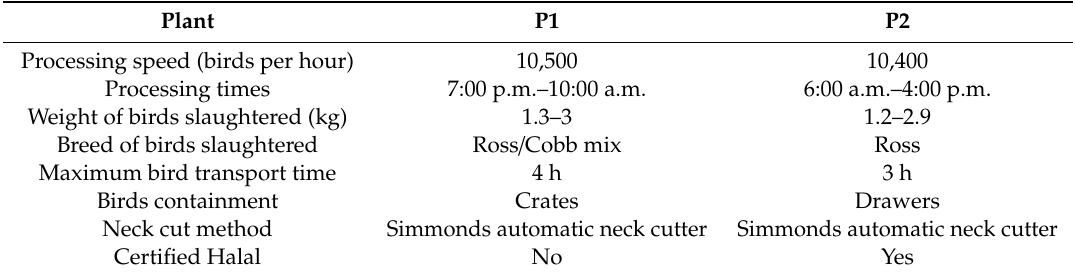
Table 1. Characteristics of the poultry plants involved in the